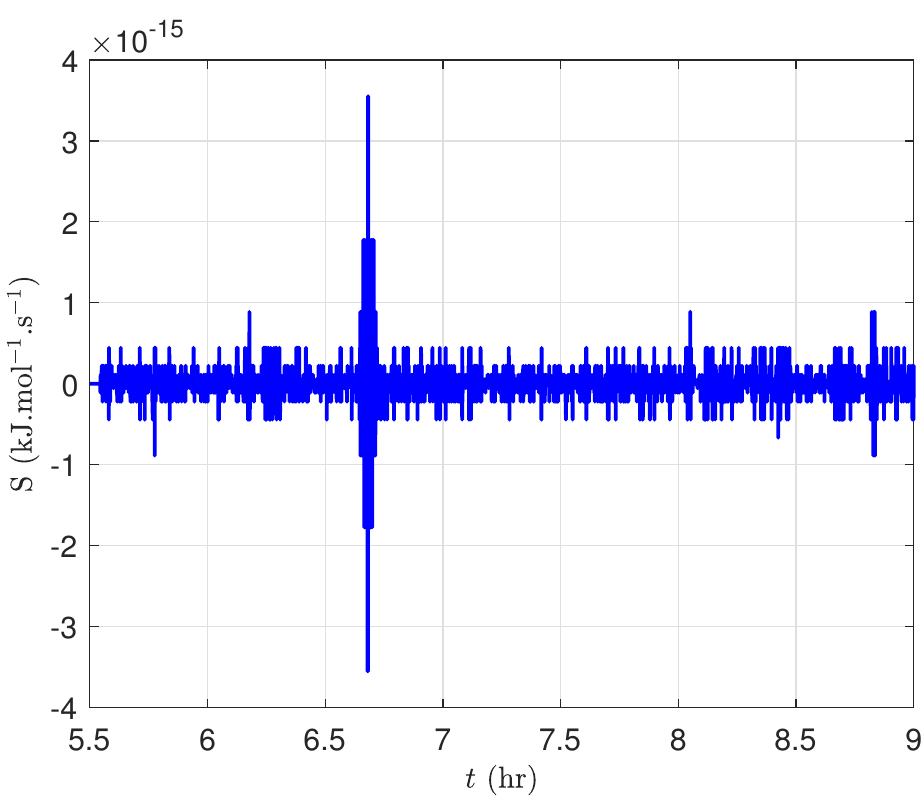
Figure 6. Sliding manifold for CFSMC with time.